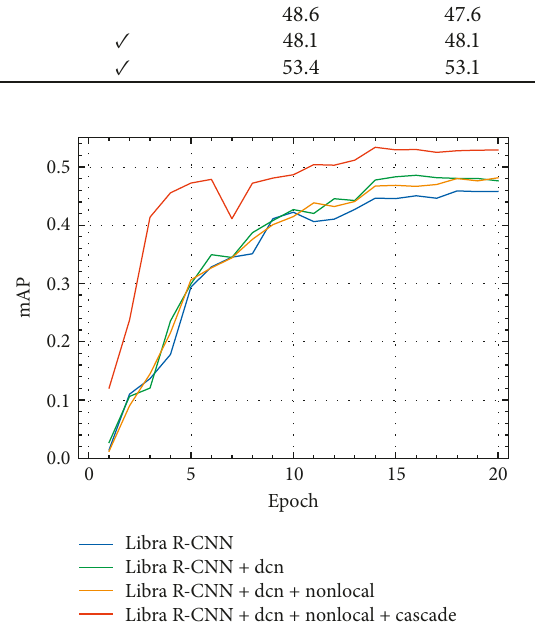
Figure 10: Visualization of the retrained Libra R-CNN curve in